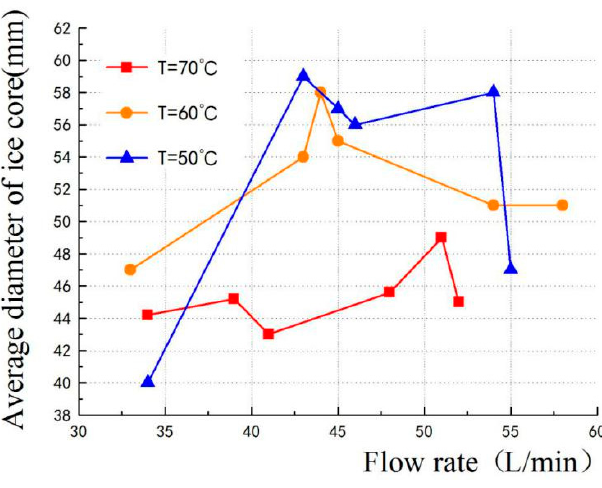
Figure 10. Average diameter of ice core versus water flow rate at different temperatures.